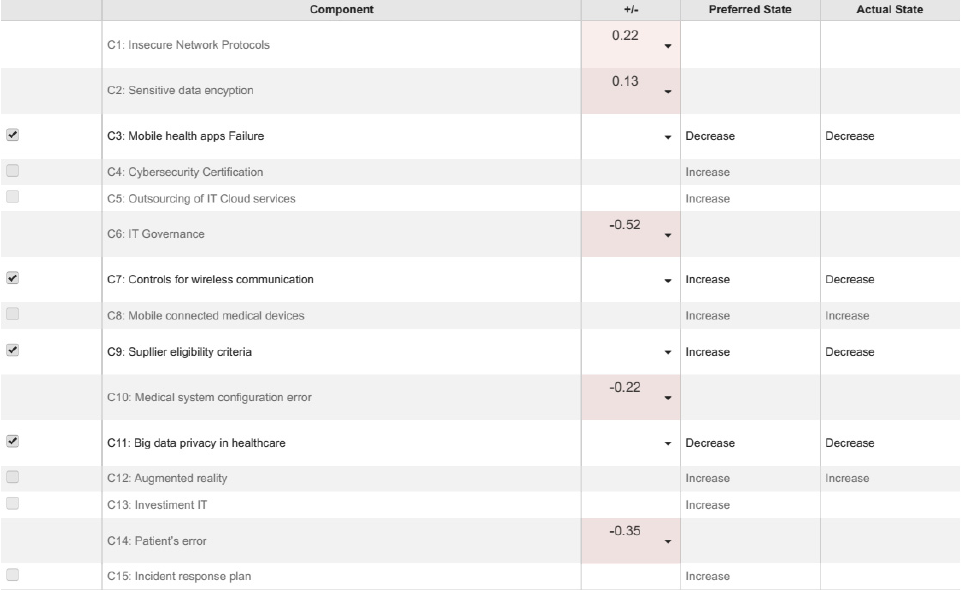
Figure 2. Final equilibrium states by the value of nodal element C1 (insecure network protocols), C2 (Sensitive data encryption), C6 (IT Governance), C10 (Medical system configuration error), and C14 (Patient’s error).